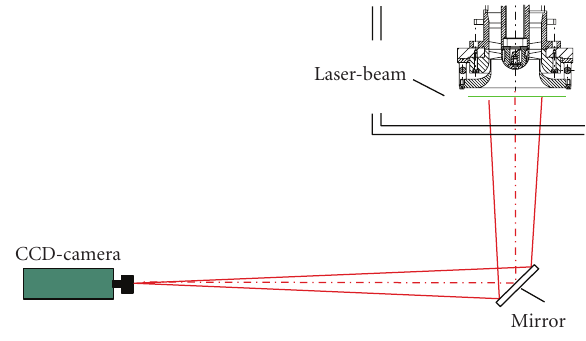
Figure 11: Optical path for investigation of the